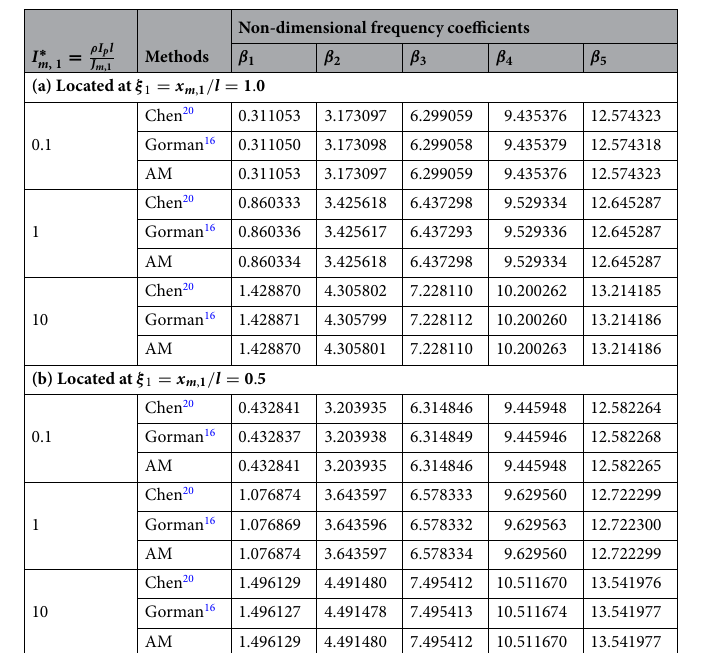
Table 1. The lowest five non-dimensional frequency coefficients for a cantilever shaft carrying a single rotary inertia.